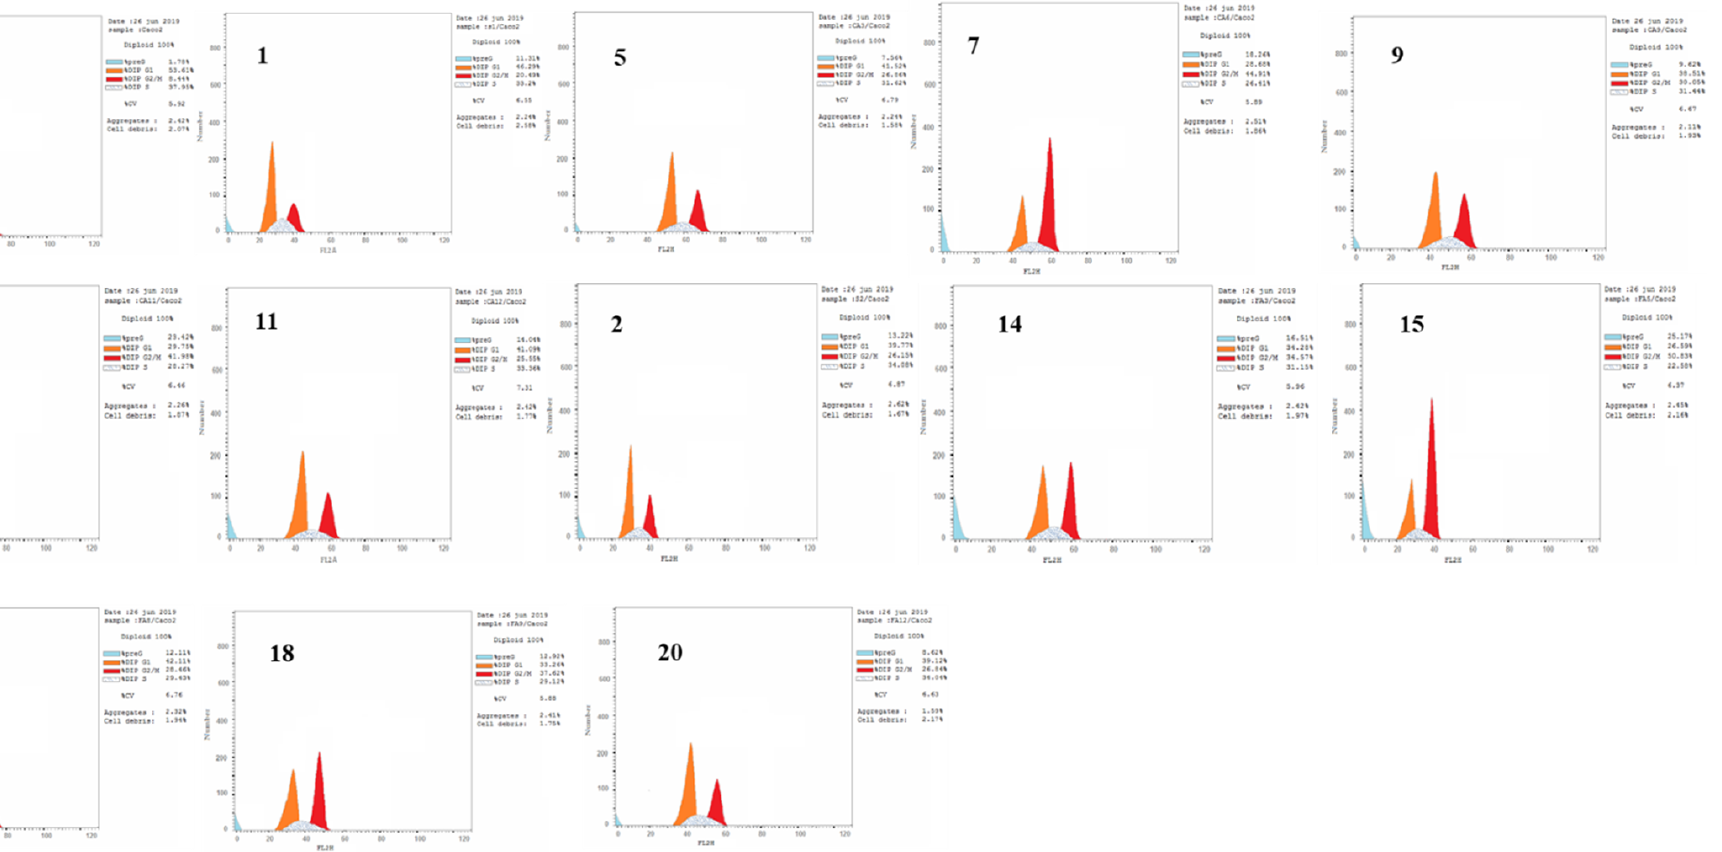
Figure 4. Cell-cycle analysis of Caco-2 cells following treatment with different derivatives and their parents; Histogram showing the percentages of cells in different cell cycle phases.